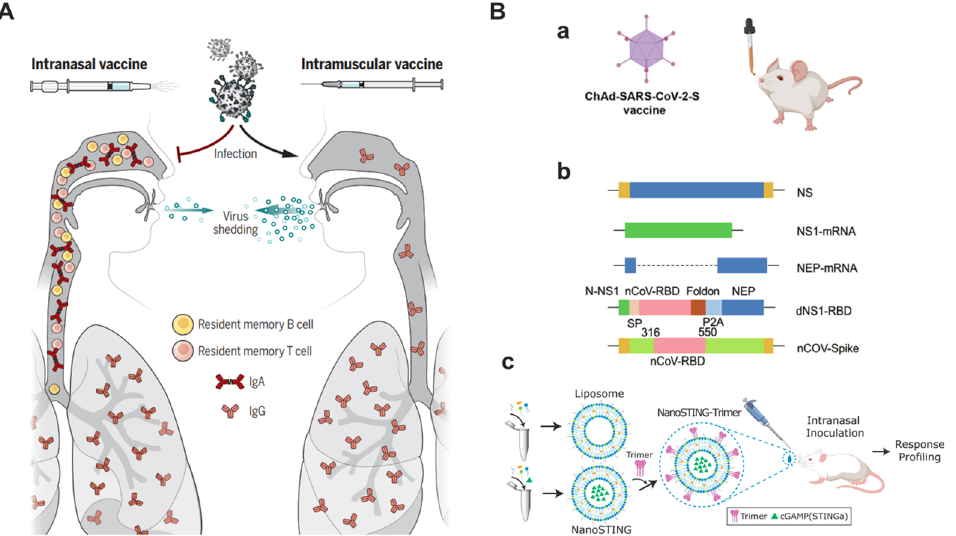
Figure 4. Respiratory mucosal delivery. ( A ) Intranasal vaccination can efficiently induce serum IgG, mucosal IgA, and tissue-resident cellular responses, thus potentially providing sterilizing immunity in the upper respiratory tract. Reproduced with permission from Ref. [120]. Copyright 2021, AAAS. ( B ) Representative mucosal-delivered vaccine candidates. (a) Adenoviral vaccine encoding stabilized spike protein. Copyright 2020, Elsevier. (b) Live attenuated influenza vaccine-based SARS-CoV-2 vac- cine. Nonstructural protein 1, NS1. Deletion of NS1, dNS1. Copyright 2022, Elsevier. (c) An intranasal subunit vaccine. Copyright 2021, Elsevier. Reproduced with permission from Ref. [33,42,122].